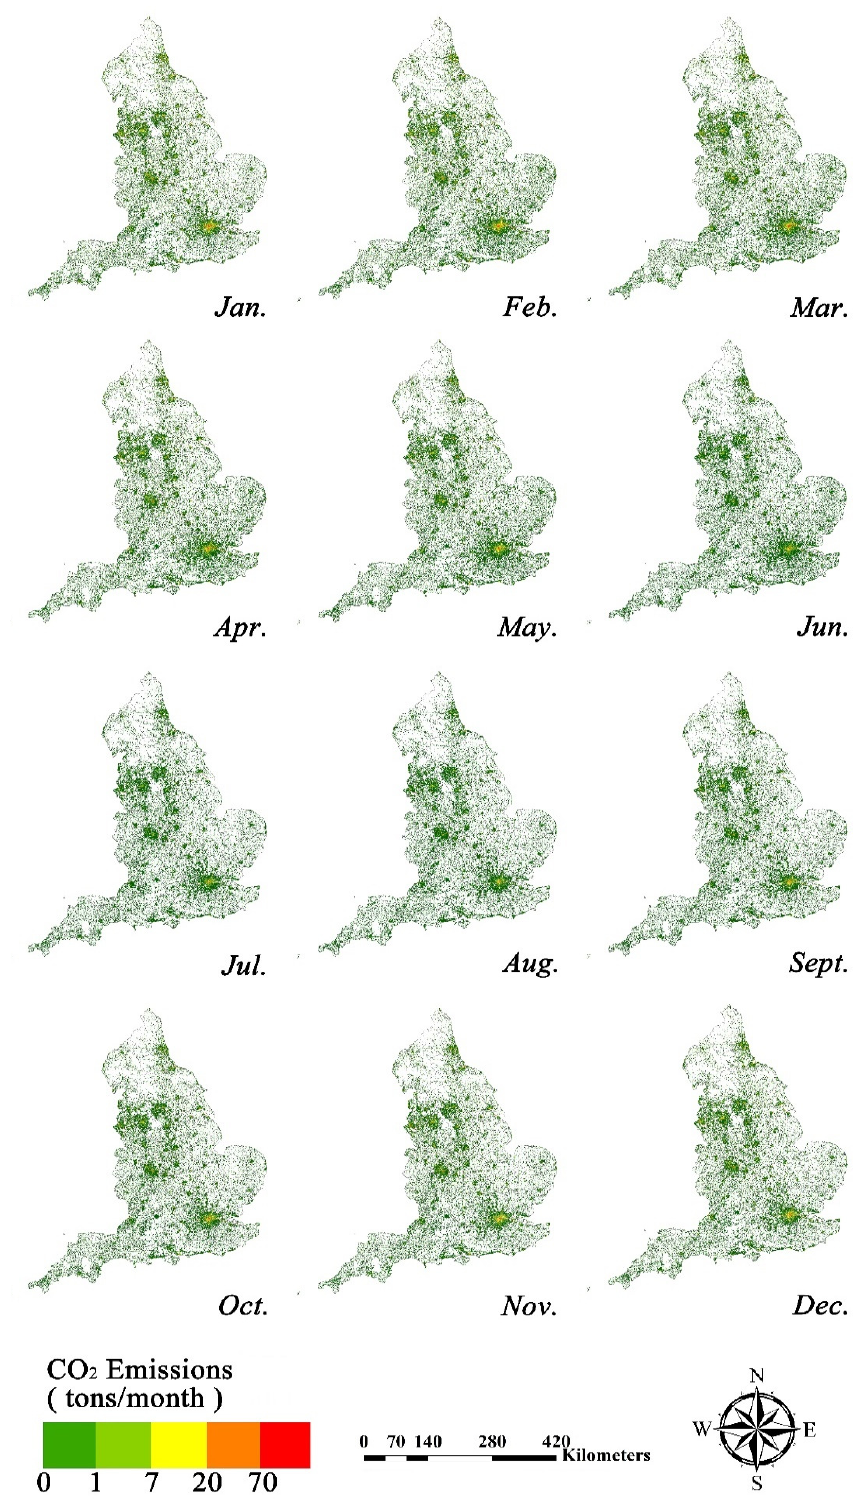
Figure 7. England monthly CO 2 emissions